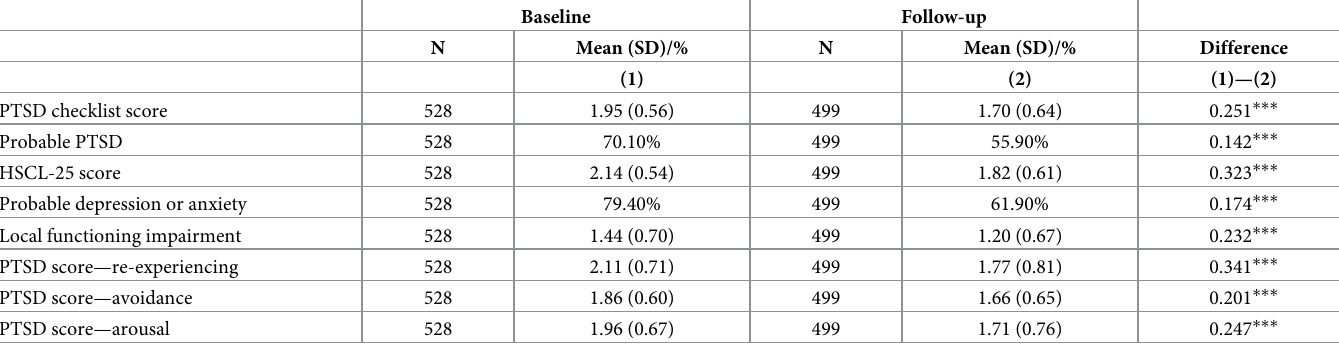
Table 3. Mental health outcomes for the no-therapy group at baseline and follow-up.